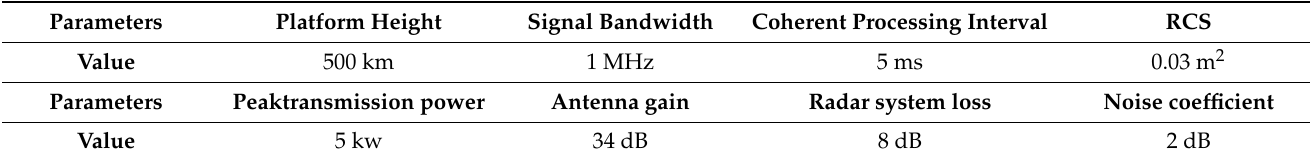
Table 1. Simulation parameters.